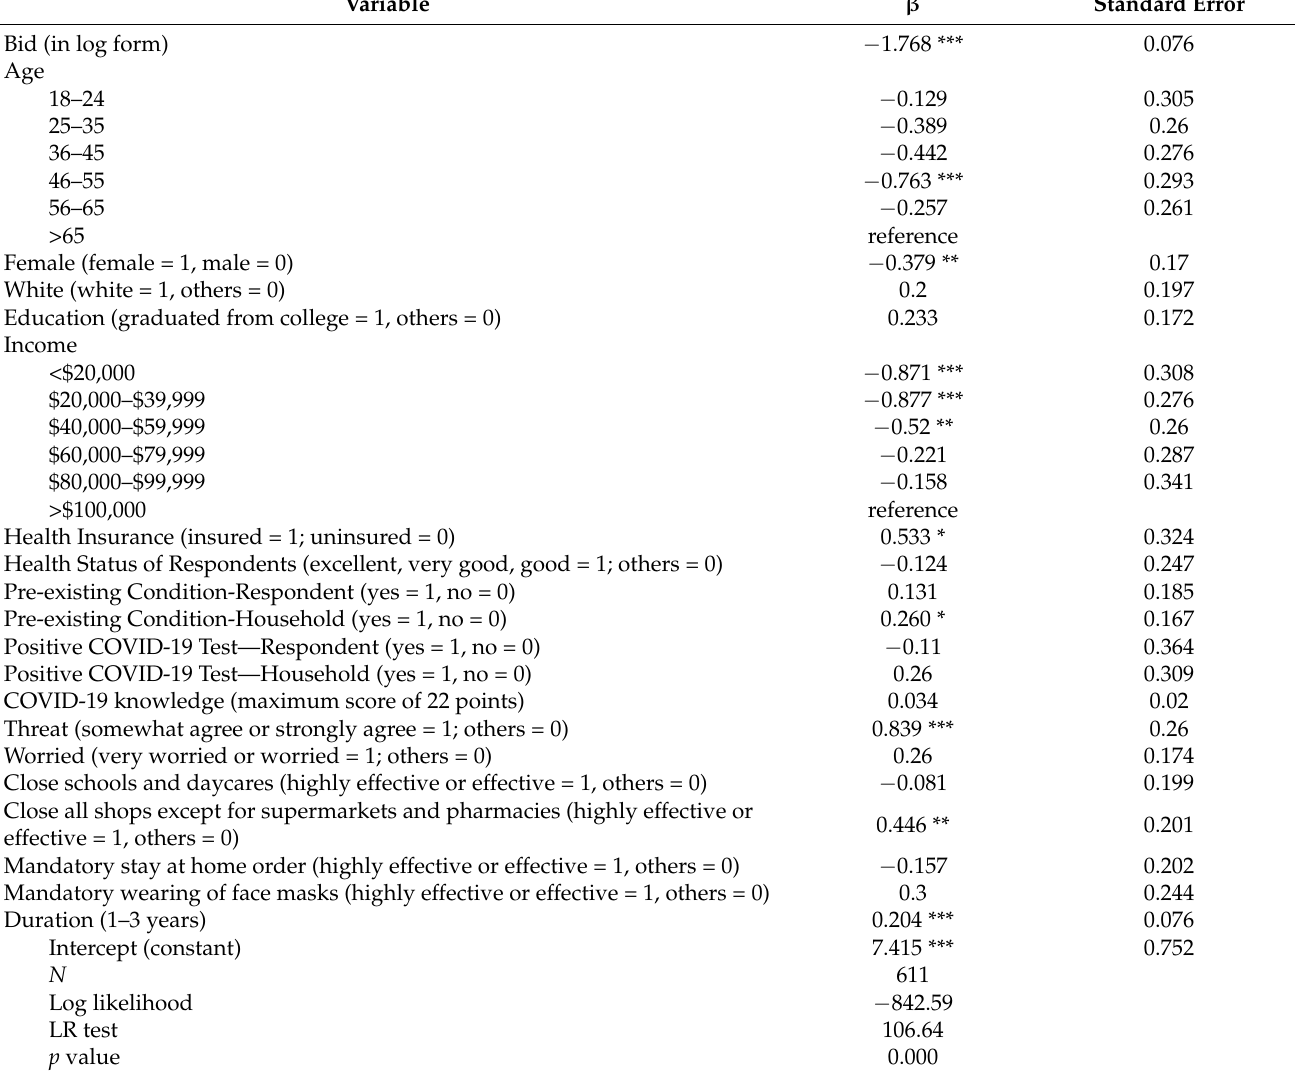
Table 3. Interval regression results of WTP for a COVID-19